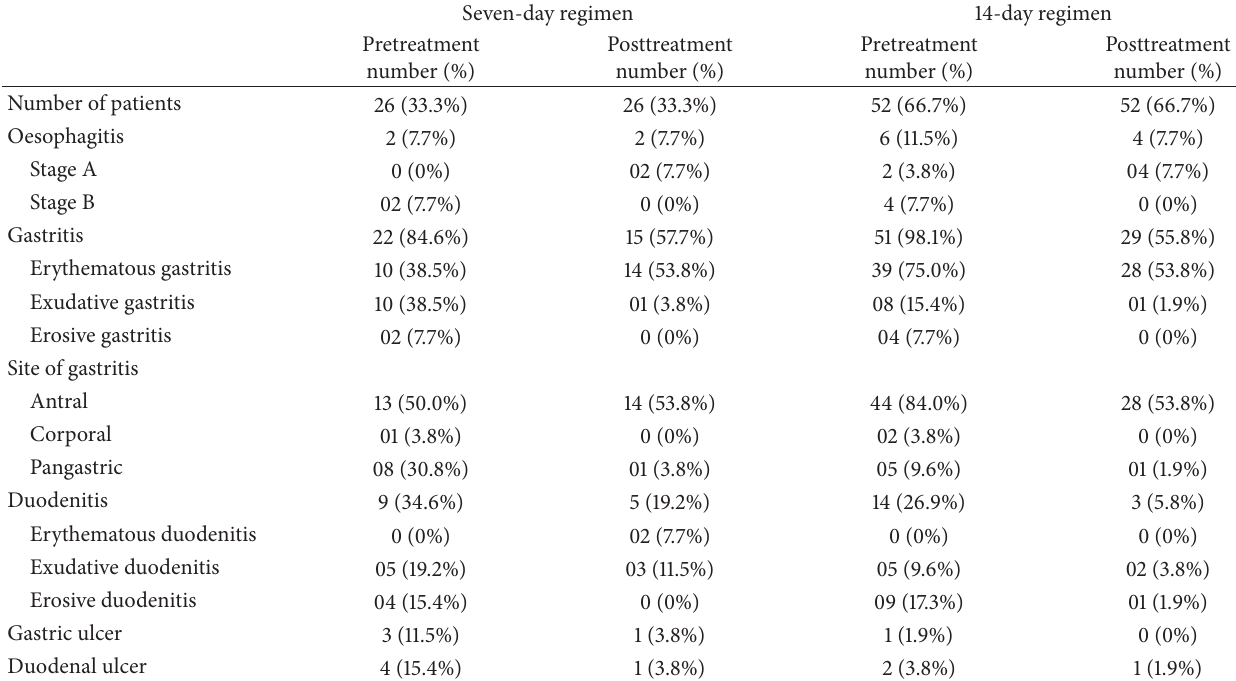
Table 2: Endoscopic features before and after treatment in both